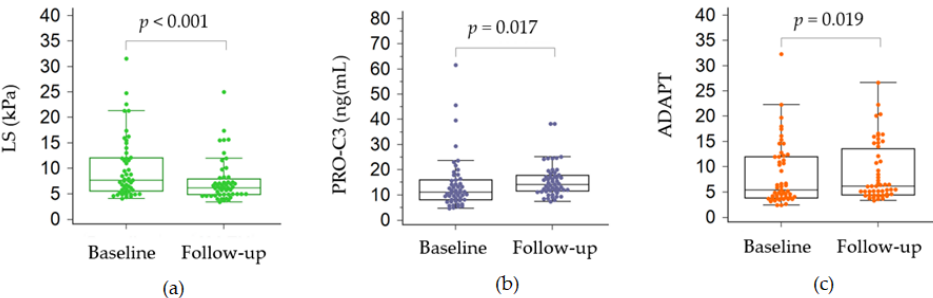
Figure 2. Comparison between baseline and follow-up values of liver stiffness ( a ), PRO-C3 ( b ) and ADAPT ( c ). ADAPT, PRO-C3 based score LS, liver stiffness; PRO-C3, N-terminal pro-peptide of type III collagen.